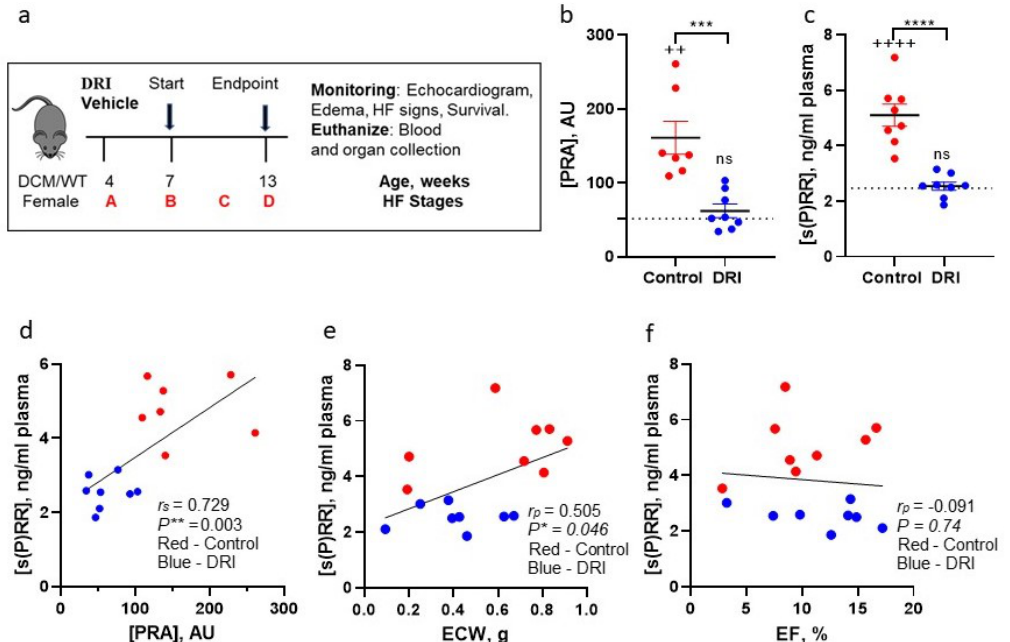
Figure 4. Plasma soluble (pro)renin receptor (s(P)RR) levels are correlated with plasma renin activity (PRA) and edema and suppressed by direct inhibition of renin activity in mice with DCM. ( a ) Experimental design: female mice with DCM (7 weeks of age corresponding stage B HF) were randomly assigned to treatment with direct renin inhibitor (DRI) aliskiren (DRI) in drinking water or vehicle (control, plain drinking water). PRA [40] ( b ) and s(P)RR ( c ) level alterations in mice with DCM at 13 weeks of age after treatment with vehicle (control) or DRI. Arbitrary units (AU). Data were analyzed with one-way ANOVA with Tukey’s multiple comparison. ( d ) Spearman correlation analysis of s(P)RR ( b ) vs. PRA ( a ). The values for the wildtype (WT, n = 4 or 7) are shown as a black dotted line for reference. Association of s(P)RR plasma levels with systemic edema assessed by ECW ( e ) or EF ( f ) by Pearson’s correlation analysis. QMR—quantitative magnetic resonance for the extracellular water retention (ECW) monitoring; EF—ejection fraction. Data are presented as the mean ± SE; * p < 0.05, ** p < 0.01, *** p < 0.001 and **** p < 0.0001 for control vs. DRI; ++ p < 0.01 and ++++ p < 0.0001 for control vs. WT; ns—not